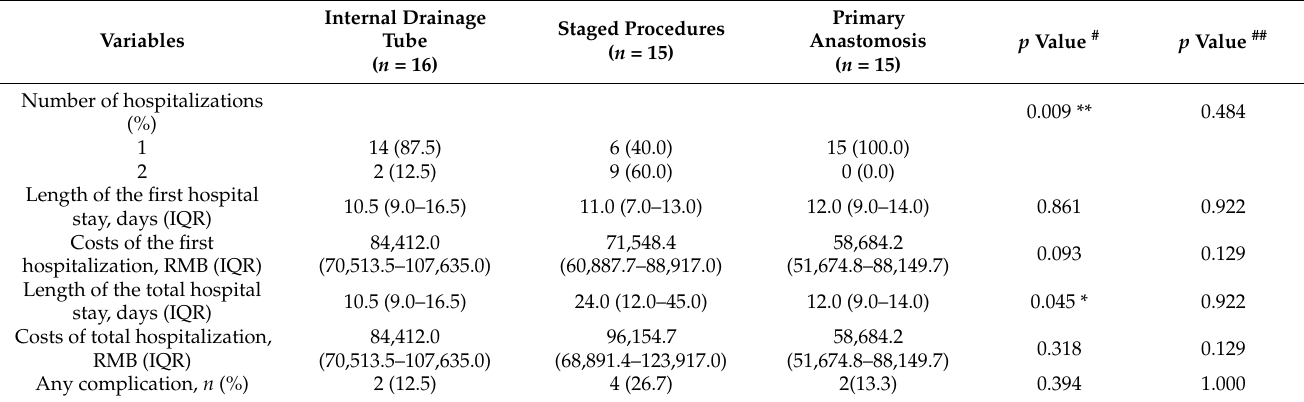
Table 4. Clinical outcomes of nonemergency patients after PSM.